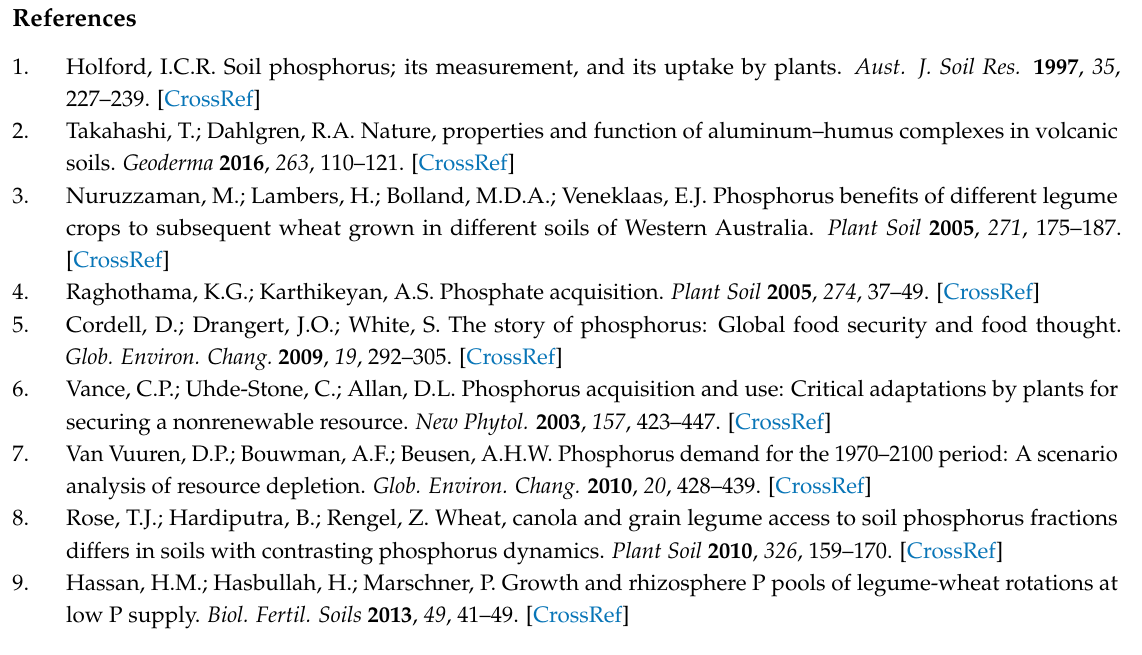
Table S1: Amount of fractionated and total soil P of rhizosphere soil and Ctrl after the pot